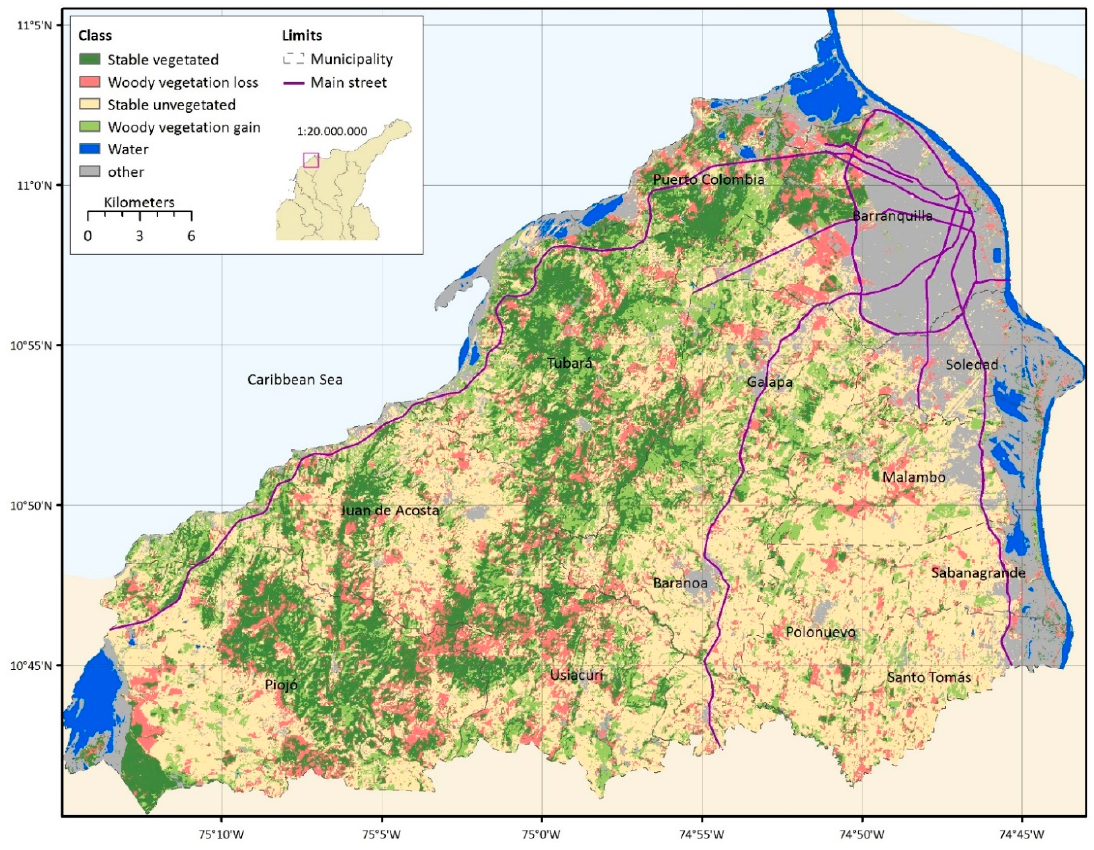
Figure 5. Vegetation cover changes in the hinterland of Barranquilla for the entire study period (1985 to